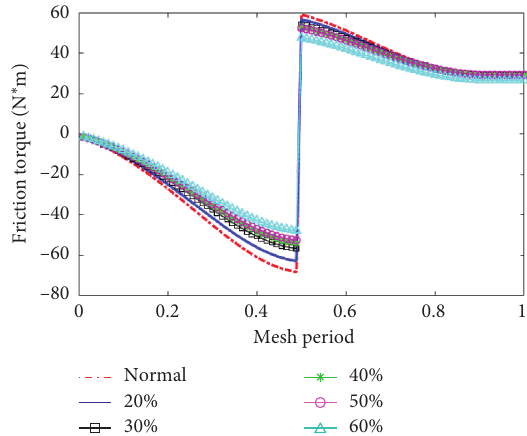
Figure 7: Time-varying friction torque with broken